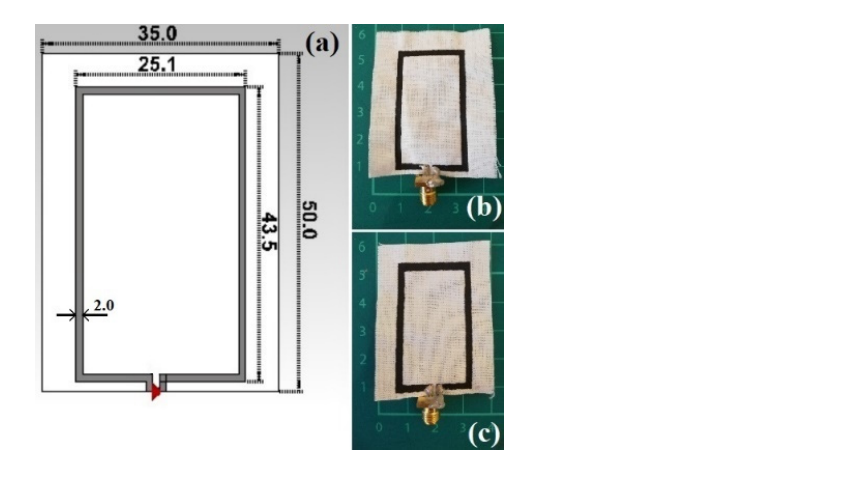
Figure 2. ( a ) Top view of the modelled textile loop printed antenna along with its dimensions in mm; Prototyped models: ( b ) CNTs/CNC—0.5:1; ( c ) CNTs/CNC—1:1.